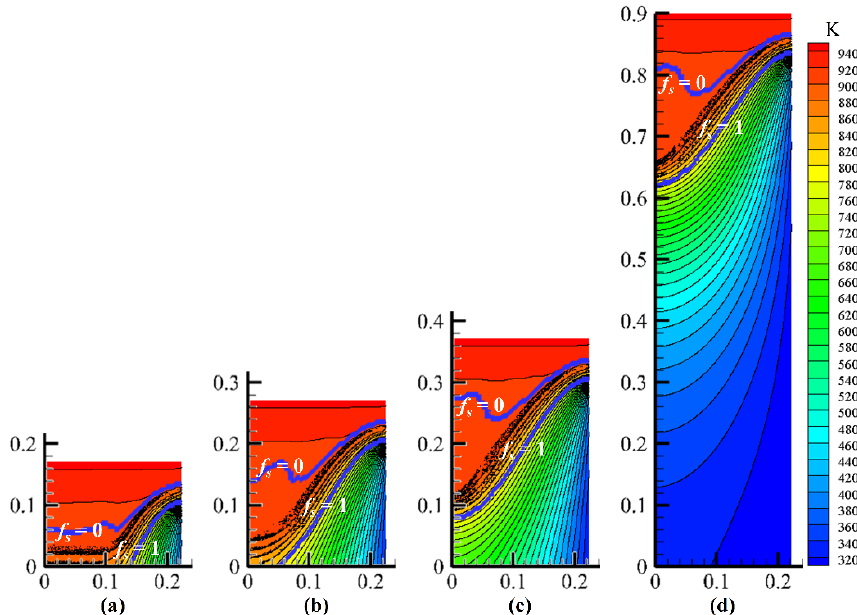
Figure 4. Evolutions of the temperature field and mushy zone predicted in the grain-refined billet (case 1): ( a ) 100 s, ( b ) 200 s, ( c ) 300 s, and ( d ) 830 s.